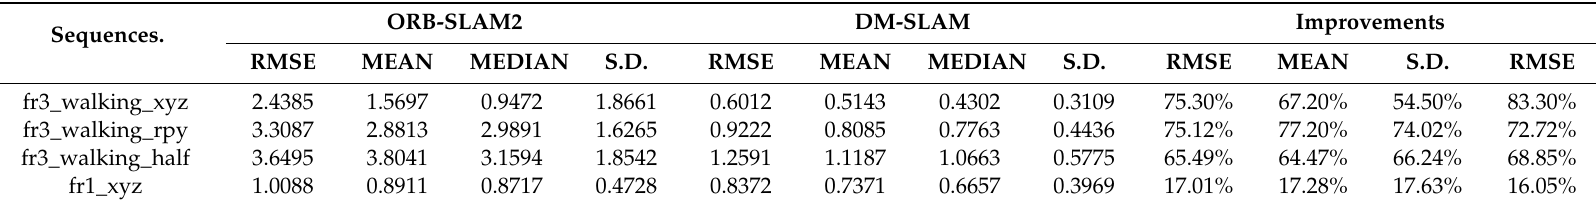
Table 2. Results of metric rotational drift (RPE).